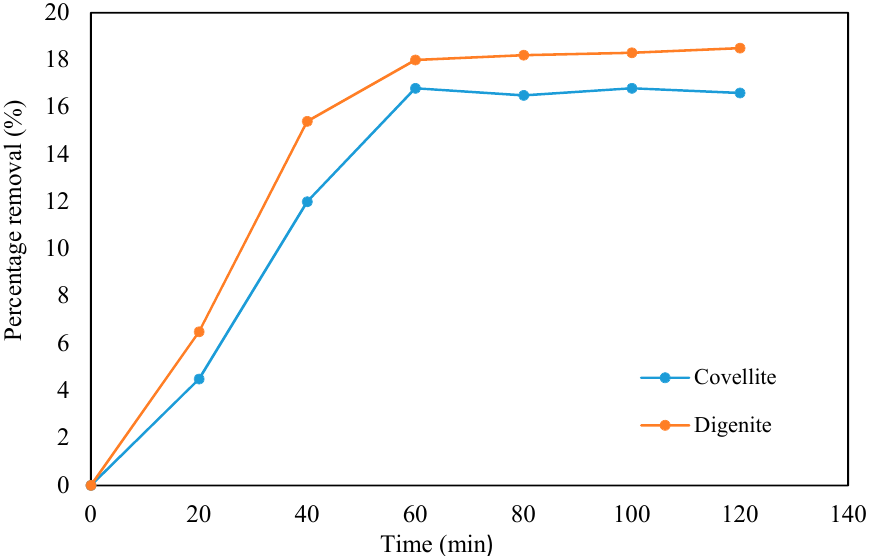
Figure 6. Adsorption equilibrium graph between the TC solution and the photocatalysts (digenite and covellite).